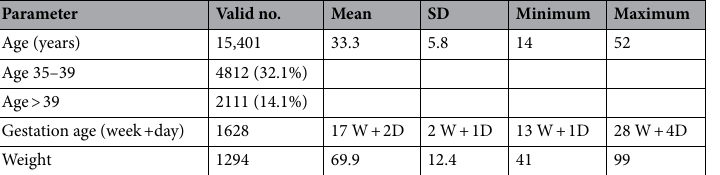
malities based on the defined indications for amniocentesis (Table 4). At least, 13.0% of cases had two or more indications for amniocentesis. Advanced maternal age (≥ 35 years) was the only criterion for indicating amnio- centesis in 11.3% of cases. The best Odds of being affected given a positive result (OAPR) was calculated for free βHCG < 0.2 MoM, i.e. one chromosomal abnormality per 1.1 amniocentesis. After this indication, three of the top OAPR values for amniocentesis indications were high risk NIPT (one chromosomal abnormality per 1.4 amnio- centesis), PAPP-A MoM < 0.26 (one chromosomal abnormality per 1.7 amniocenteses) and Free BhCG MoM > 5.0 (one chromosomal abnormality per 2 amniocenteses). On the other hand, the poorest OAPR was obtained for intermediate risk for Trisomy 21 used for FTS (one chromosomal abnormality per 52.2 amniocenteses).